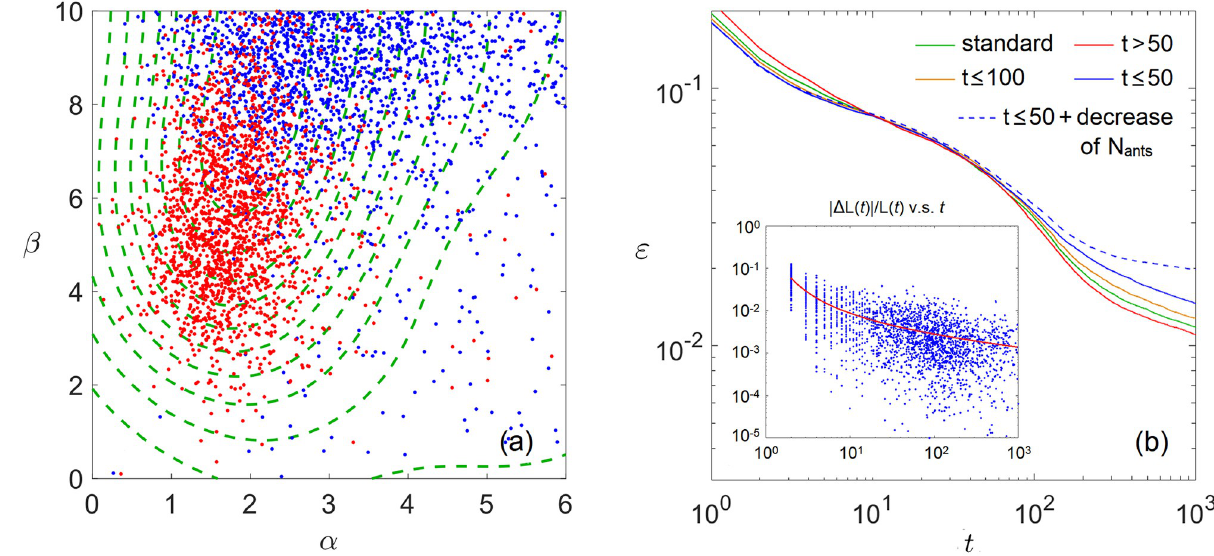
Fig 3. (a) The equilibrium contributor distribution under the survival rules of t � 50 (blue) and t > 50 (red). Dashed contours are those of the standard N = 100 distribution in Fig 1d. (b) The error curves ε ( t ) of different survival rules. Inset shows normally trained contributor distribution in terms of improvement percentage v.s. problem